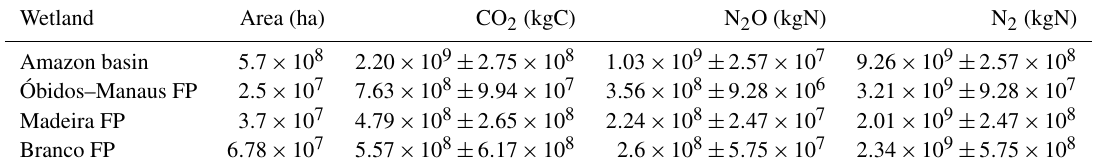
Table 1. Average yearly CO 2 emissions (kgC-CO 2 ), N 2 O emissions (kgN-N 2 O) and N 2 emissions (kgN) for the Amazon basin and the three main floodplains. The values are calculated for a N 2 O / N 2 ratio of 0.1. Wetland